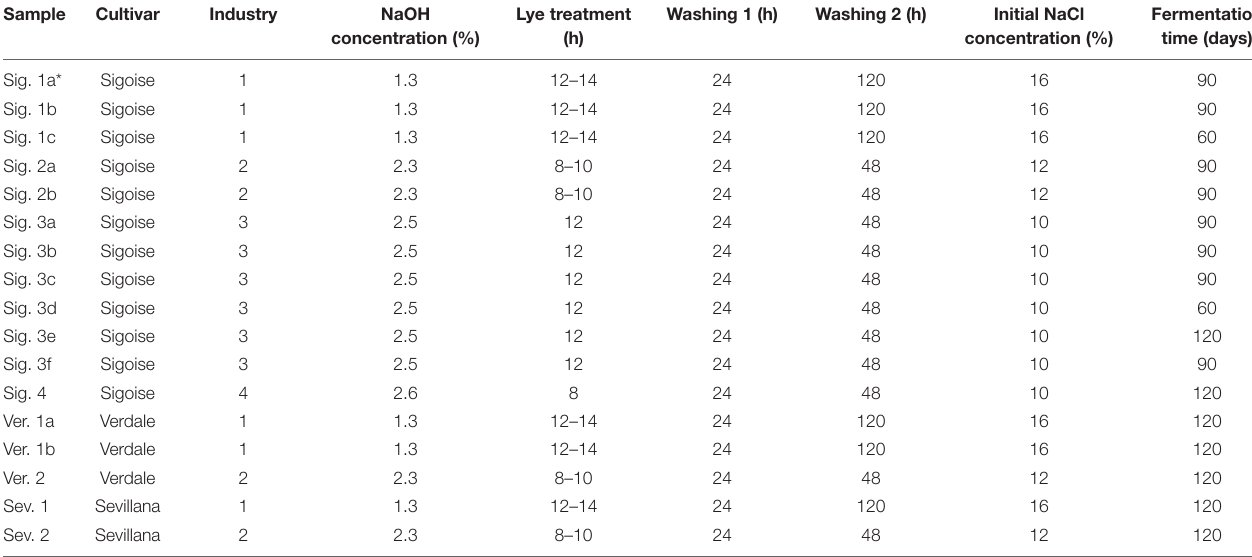
TABLE 1 | Characteristic processing of the Spanish-style green olives brines collected from industrial tanks.